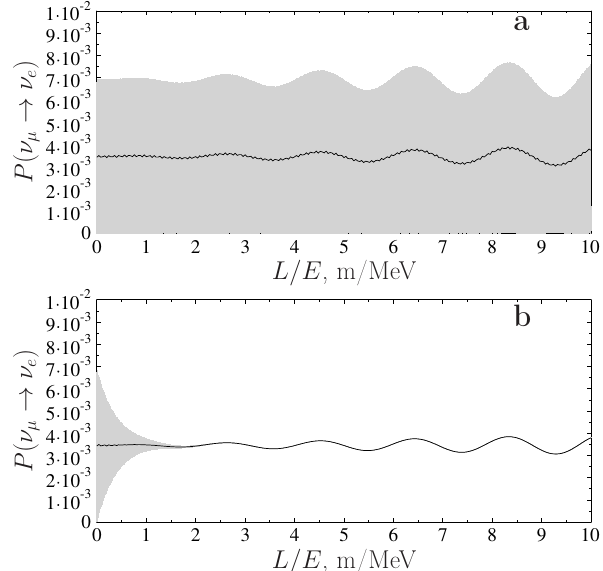
Figure 1. The probability of appearance of ν e depending on the ratio of the distance L from the source to the neutrino energy E in the beams of ν µ for stable ( a ) and decaying ( b ) sterile neutrinos with masses m 4 = 1.14 eV, m 5 = 7 keV and m 6 = 1 MeV and with decay widths Γ 4 = 10 − 14 eV, Γ = 10 − 7 eV and Γ = 10 − 5 eV. For matrix U 5 6